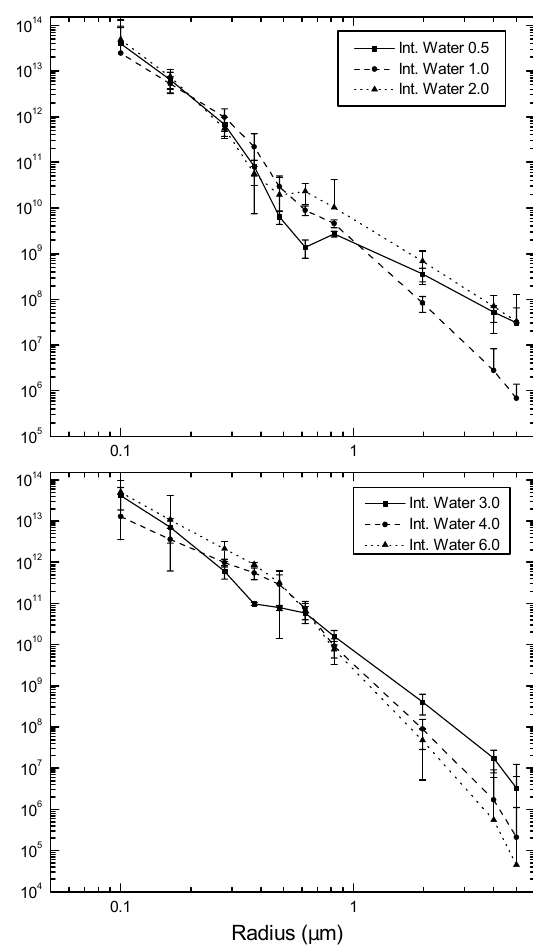
Fig. 4. Column integrated aerosol number density size distributions for different conditions of atmospheric humidity in terms of inte- grated water vapour